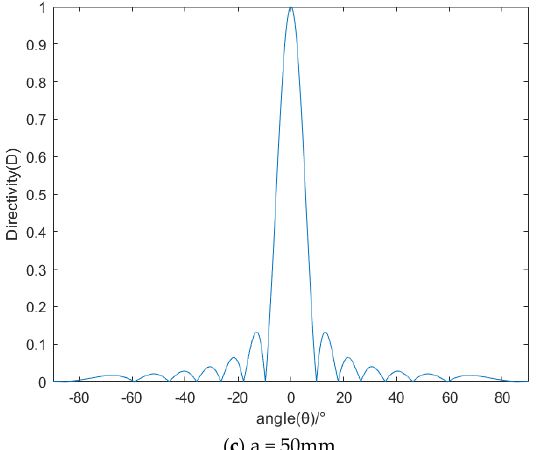
Figure 11. Directivity pattern of the piston transducer with different radii of 30 mm ( a ), 40 mm ( b ) and 50 mm ( c ).